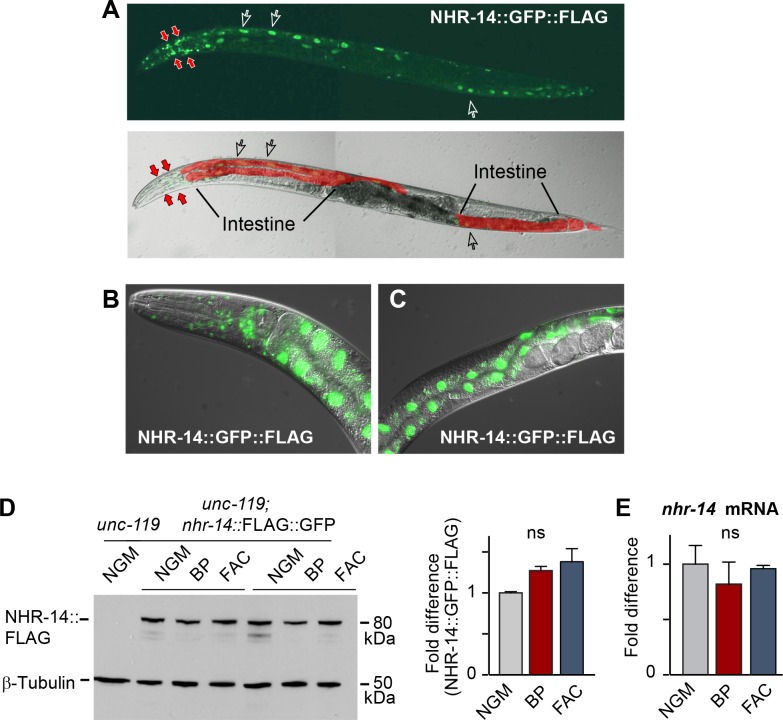
NHR-14 is highly expressed within intestinal and head cell nuclei and is not regulated by iron.(A) NHR-14::GFP::FLAG expression in young adult transgenic worms assessed by confocal microscopy (40x). Open arrows, intestinal nuclei; red arrows, head cells. (B) GFP expression of NHR-14::GFP::FLAG in cells in the (B) head and (C) intestine (60x). (D) Western blot analysis of NHR-14::GFP::FLAG non-injected worms (unc-119) versus NHR-14::GFP::FLAG worms grown in NGM, NGM-BP (low iron) and NGM-FAC (high iron) (two biological replicates are shown); right panel, quantification of NHR-14::GFP::FLAG expression (n = 3 biological replicates). The blot was simultaneously probed with FLAG and β-tubulin antibodies. (E) qPCR of nhr-14 expression in wild-type N2 adults grown in NGM, NGM-BP and NGM-FAC normalized to N2 worms grown in NGM (n = 3 biological replicates). Values are expressed as mean ± SEM and are compared by unpaired two-tailed Student’s t test; ns, not significant.